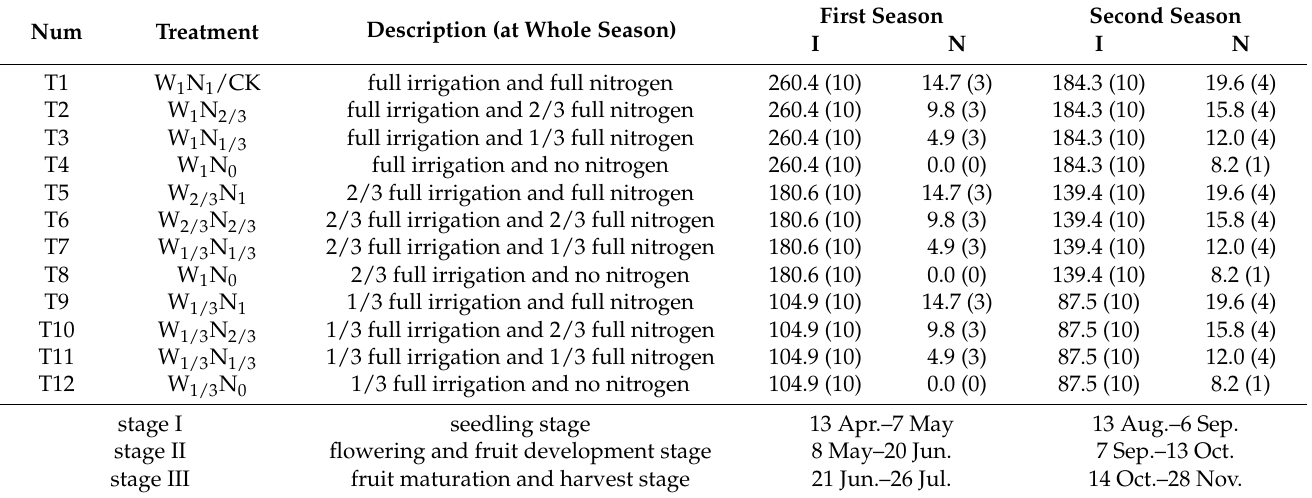
Table 1. Description of irrigation and nitrogen amount in different